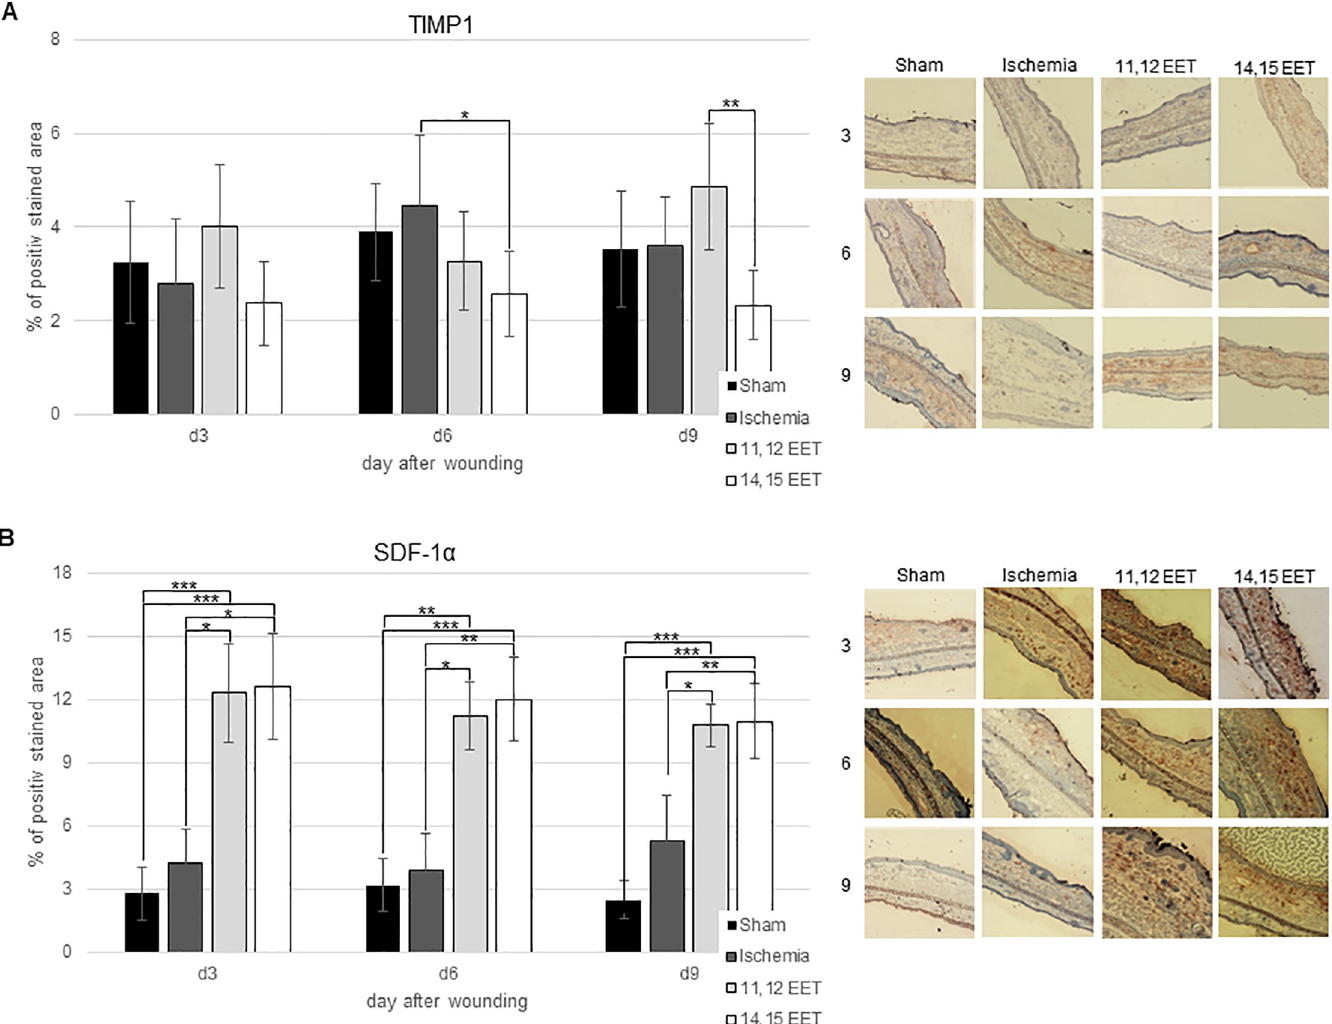
Fig 6. A: Percentage of TIMP1 positive area on day 3, 6 and 9 after wounding of control, ischemic and 11,12 as well as 14,15 EET treated ischemic wounds. On the right representative pictures of immunohistological staining. B: Percentage of SDF-1 α positive area on day 3, 6 and 9 after wounding of control, ischemic and 11,12 as well as 14,15 EET treated ischemic wounds. On the right representative pictures of immunohistological staining (data is shown as mean ± SD; n = 8 ). � p < 0.05, �� p < 0.01, ��� p < 0.001.